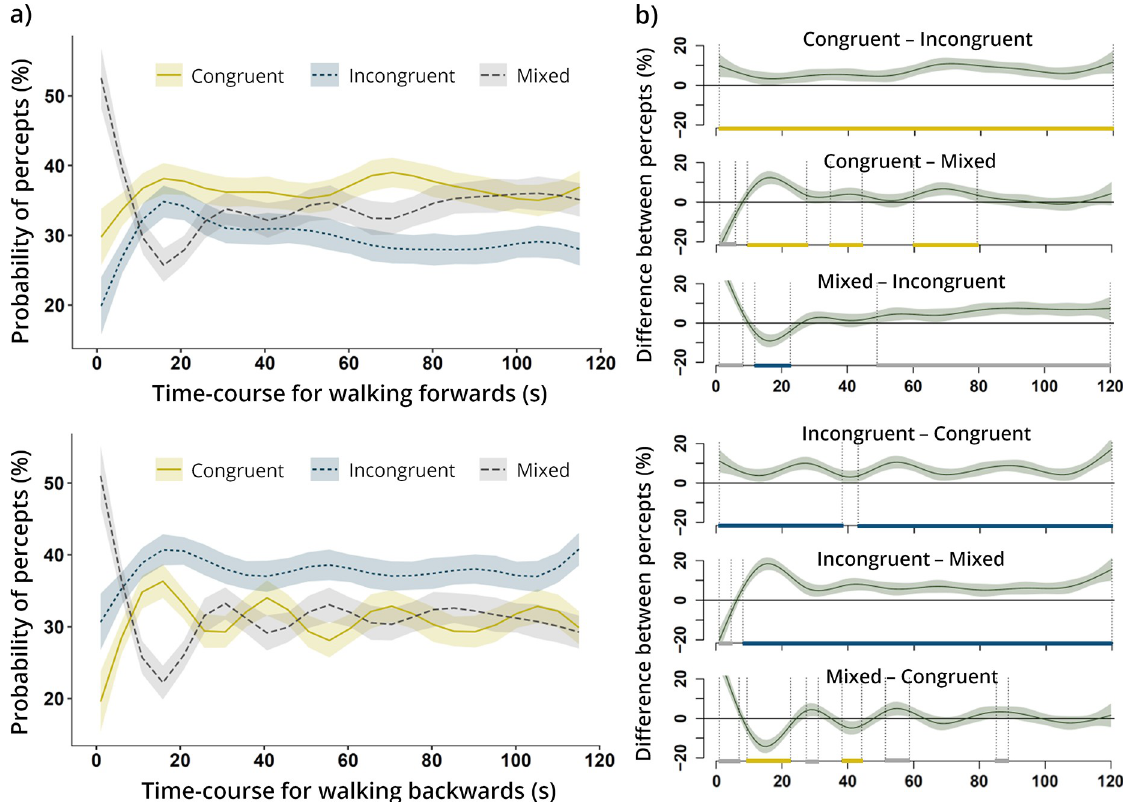
Fig 3. Time-course changes in perceptual awareness of optic flow patterns. ( a ) Non-linear smooths (fitted values) representing the probability of perceiving congruent, incongruent, and mixed percepts over the time of average blocks. The pointwise 95%-confidence intervals are depicted by the shaded bands. ( b ) Pairwise contrasts between probabilities of different percepts. Time intervals during which one of the compared percepts was significantly more likely to be perceived (i.e., shaded confidence bands do not overlap with zero) are bracketed by vertical dotted lines and marked by coloured segments on the x-axis (with the colours indicating the predominant percept).